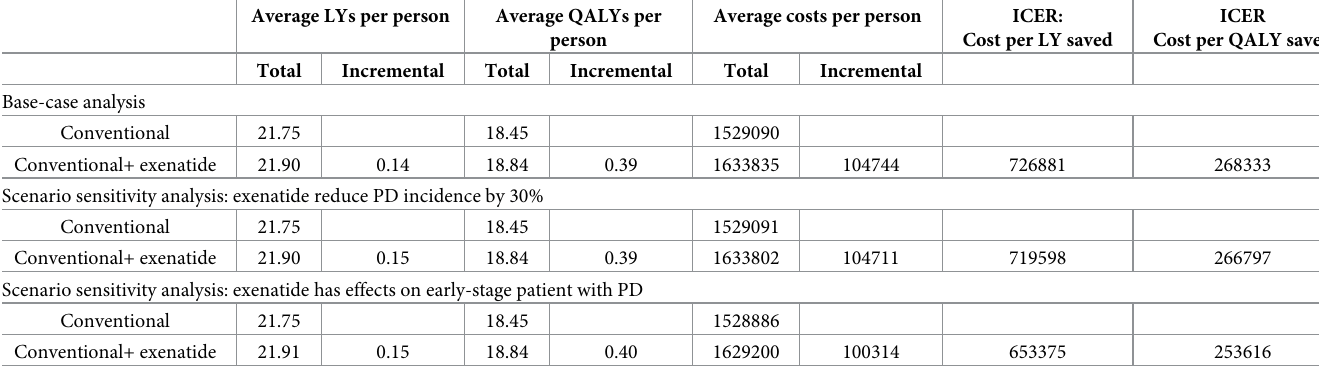
Table 4. Results of the cost-effectiveness analyses: Base-case analysis and scenario sensitivity analyses in Aim 3 (PD + DM).